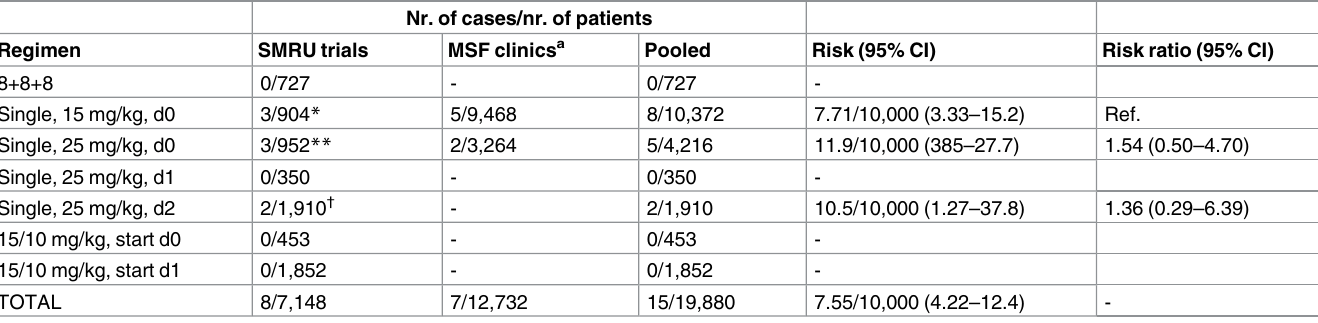
Table 5. Serious neuropsychiatric events associated with MQ